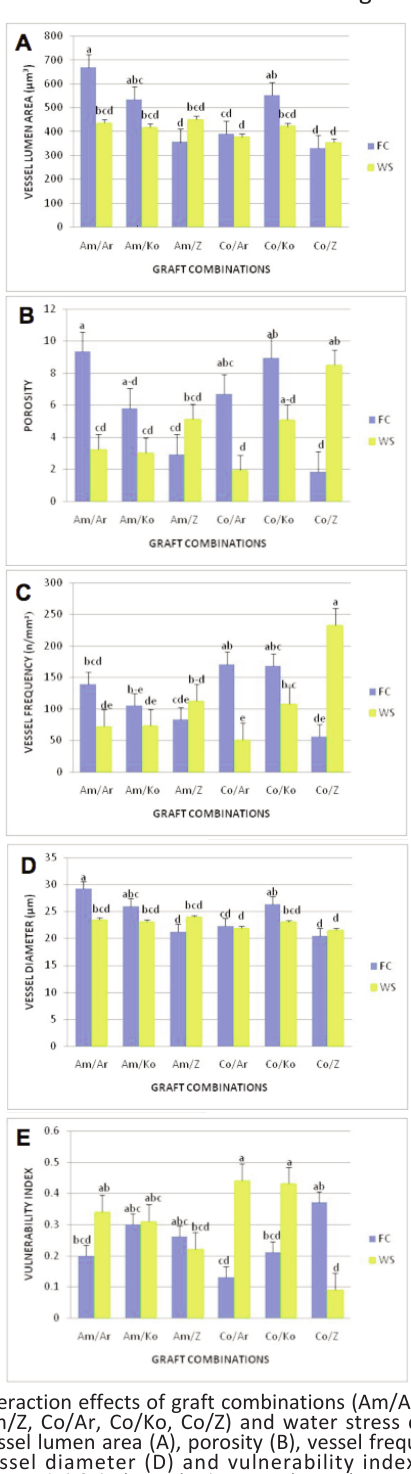
Fig. 1 - Interaction effects of graft combinations (Am/Ar, Am/Ko, Am/Z, Co/Ar, Co/Ko, Co/Z) and water stress deficit on vessel lumen area (A), porosity (B), vessel frequency (C), vessel diameter (D) and vulnerability index (E). Am (Amagdalifolia), Ar (Arbequina), Ko (Koroneiki), Co (Conservalia) and Z ( Zard). Vertical bars indicate SE. Each value represents the mean ± SE of 3 replicates. Means with the same letters are not significantly different (P>0.05) using Duncan Multiple Range